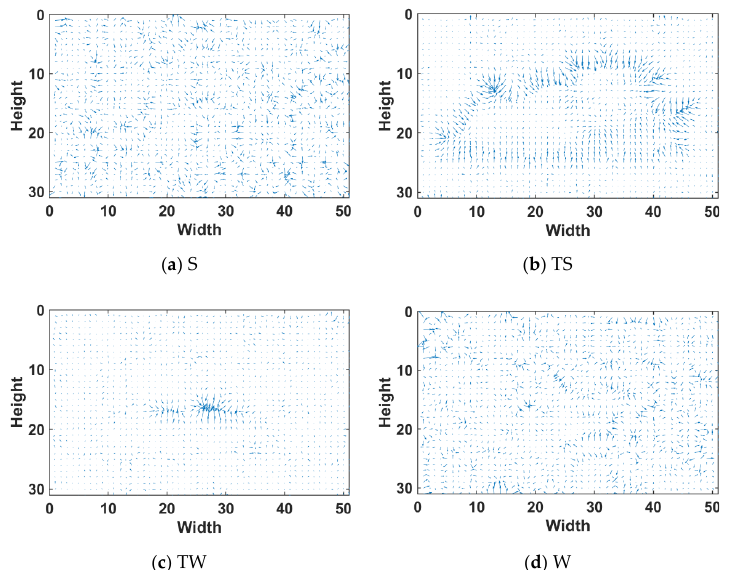
Figure 4. Gradient vector illustration of the local area of the calm sea image. ( a ) Sky area; ( b ) target with complex contours area; ( c ) dim point target area; ( d ) sea clutter area.